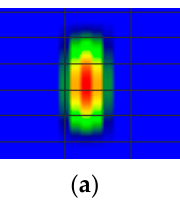
Figure 7. Field distribution of the proposed optical power splitter.